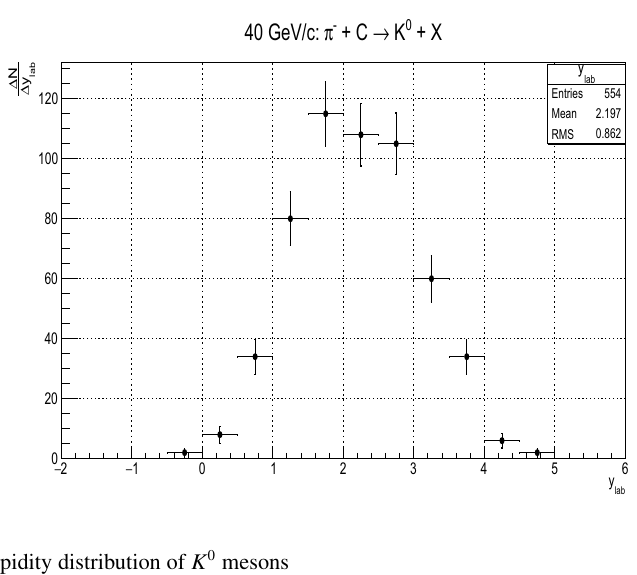
Figure 4. Rapidity distribution of K 0 mesons